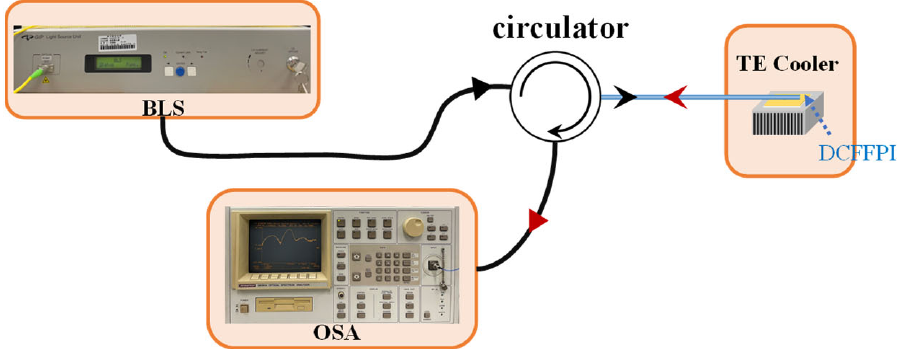
Figure 3. Experimental setup for simultaneously measuring the TEC and TOC of a polymer.